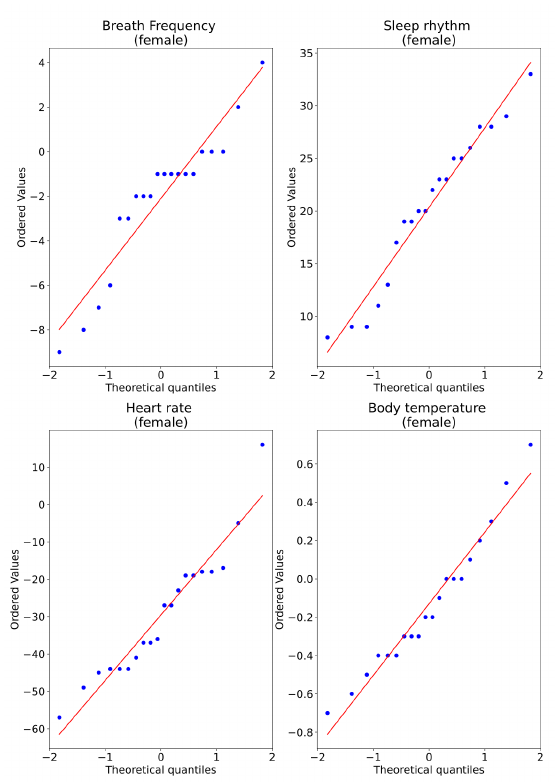
Figure 17. Q–Q plot of measurements captured for two conditions, without and with sensors, for female